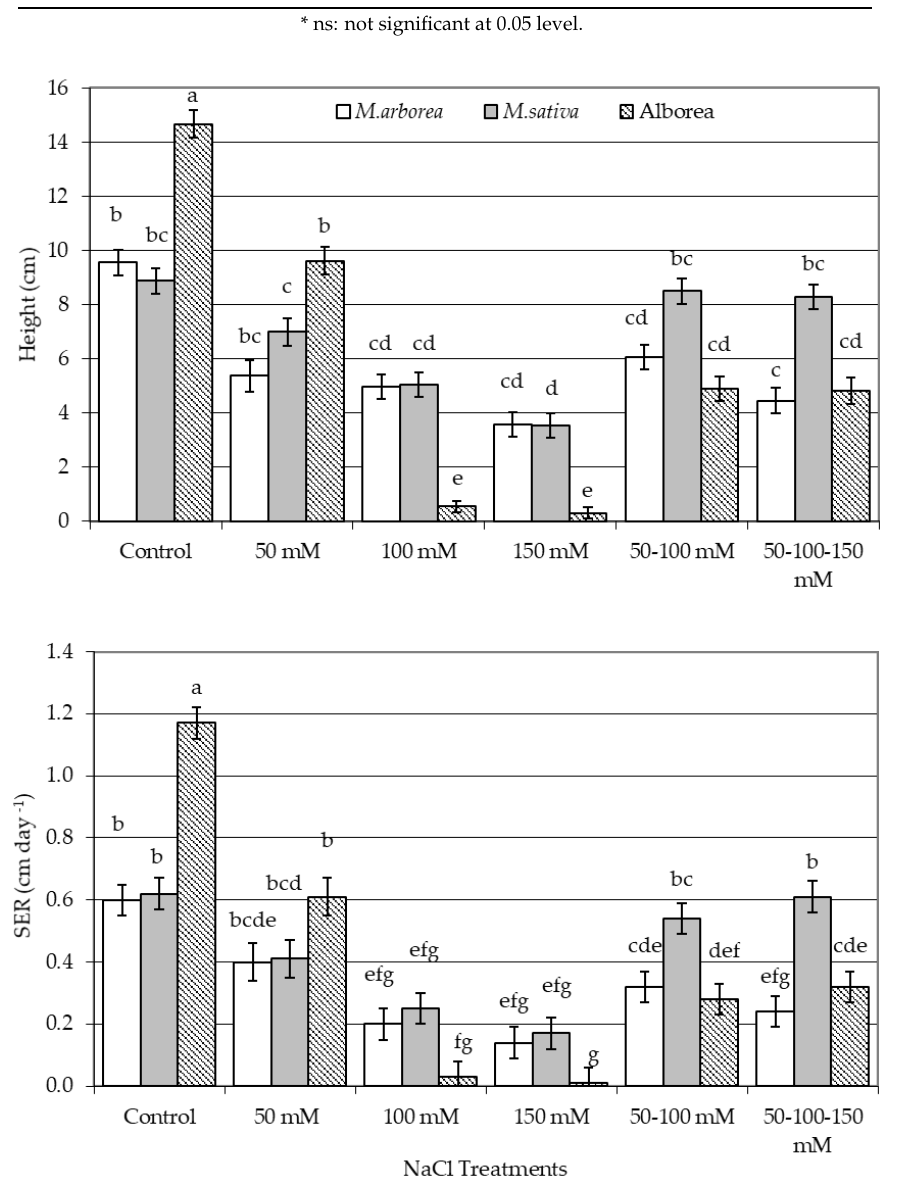
Figure 1. The stem height, and the stem elongation rate (SER) of M. arborea (M. ar), M. sativa (M. sa), and Alborea (Al) under control, 50 mM, 100 mM, 150 mM, 50 – 100 mM, and 50 – 100 – 150 mM NaCl. The vertical bars indicate the mean ± standard error (SE) of five independent samples. The different letters refer to the significant differences at p < 0.05 (Tukey’s test). Table 3. Indicative data of sodium and potassium content (mg·g − 1 dry weight (dw)) of M. arborea , M. sativa , and Alborea.